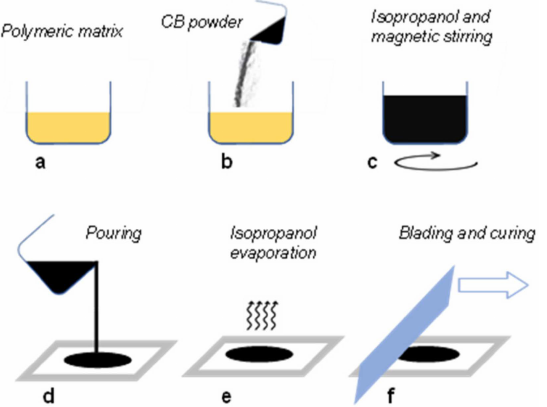
Figure 2. CB-based electrode manufacturing: ( a ) epoxy-polyurethane mixing; ( b ) CB powder ad- dition; ( c ) CB dispersion by magnetic stirring with isopropanol; ( d ) pouring on Teflon substrate;